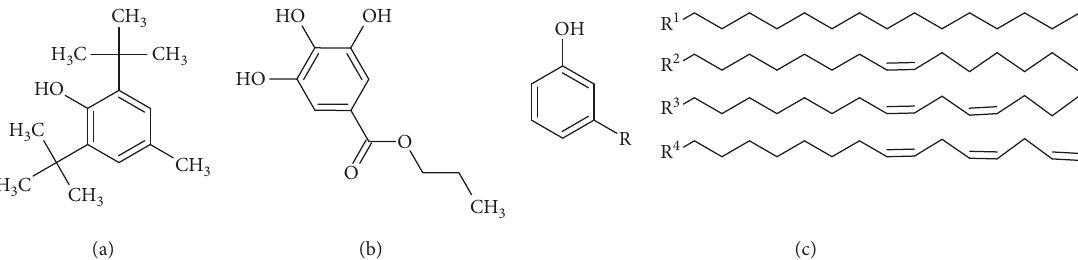
Figure 1: Chemical structures of antioxidants: (a) 2,6-di-tert-butyl-4-methylphenol (DBPC); (b) propyl 3,4,5-trihydroxybenzoate (PG); (c) cardanol.